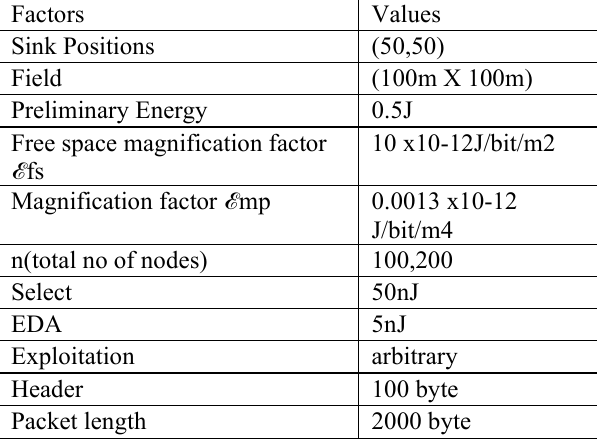
Figure 10 . Comparison of various protocol in terms of FND, QND, HND for